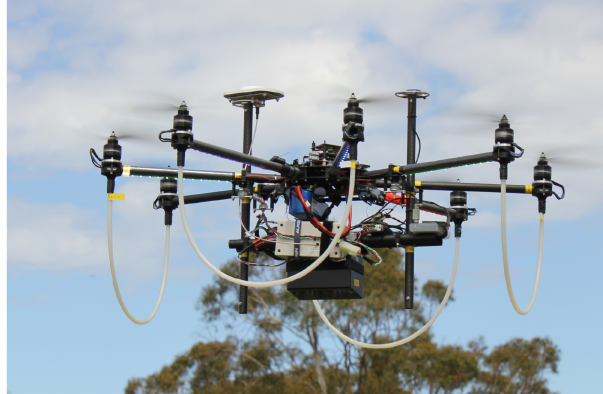
Figure 1. The multi-rotor UAV platform used within this study.